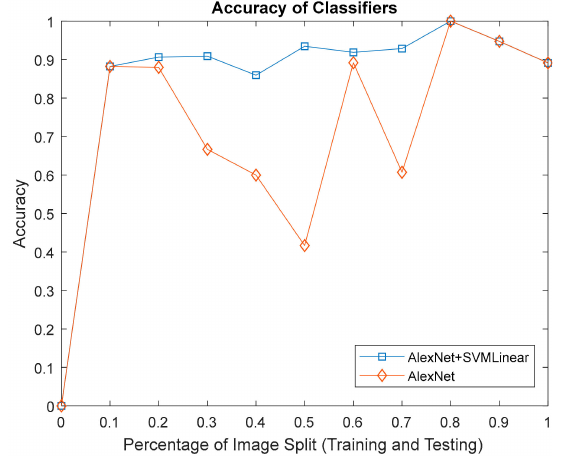
Figure 21. The accuracy of AlexNet and AlexNet-SVM classifier.